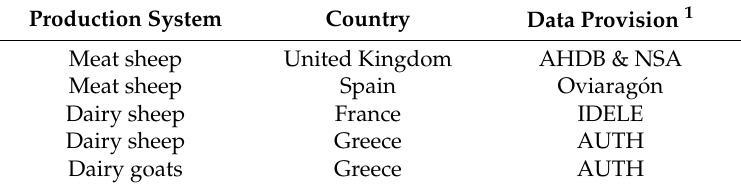
Table 1. Data provision for default values and acceptable ranges per production system and